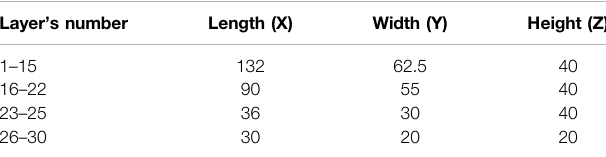
TABLE 2 | Element size, in microns, for each meshed layer of the part-scale simulation. Layer ’ s number Length (X) Width (Y) Height